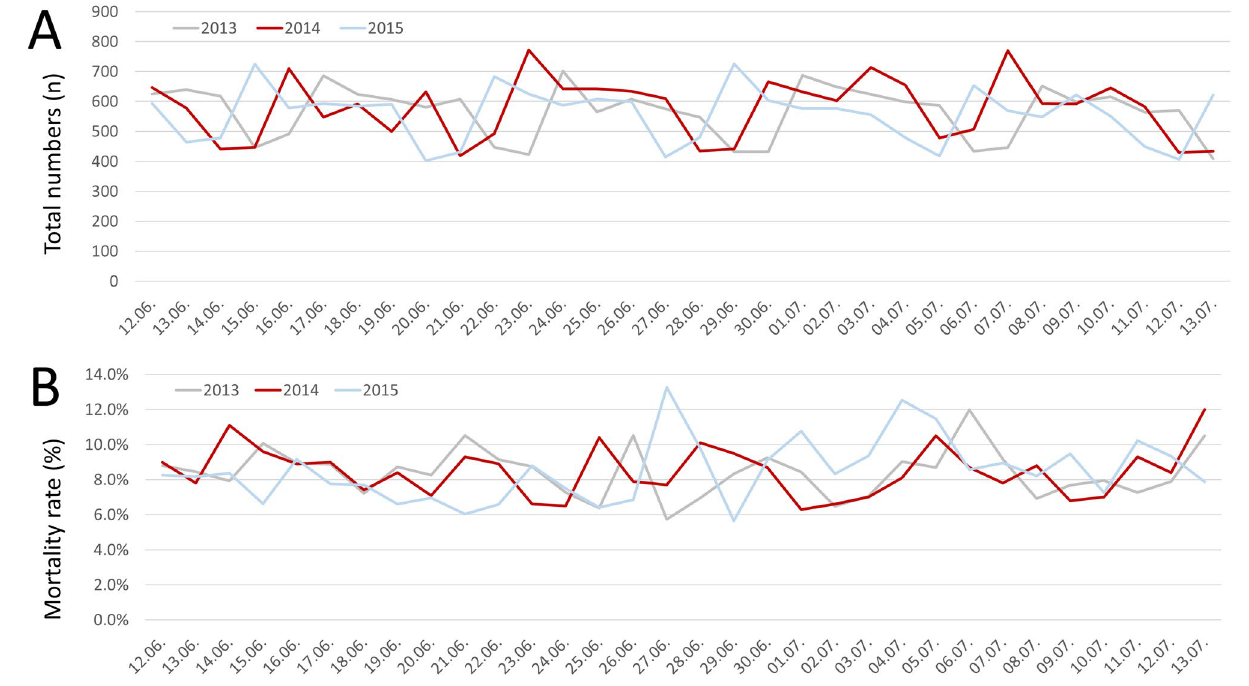
Figure 3. Absolute numbers of patients admitted due to MI events ( A ) and in-hospital mortality rates ( B ) across the observational periods 2013, 2014 and 2015. The data of the year 2013 is visible as grey line, 2014 as red line and the 2015 as blue line.